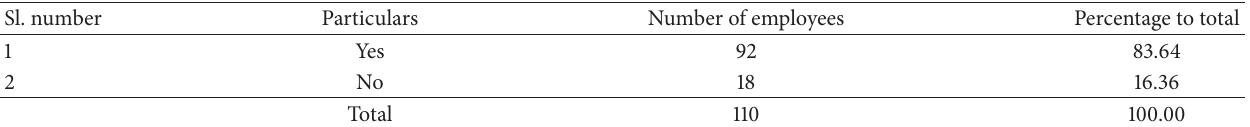
Table 6: Attended the meeting of banks.